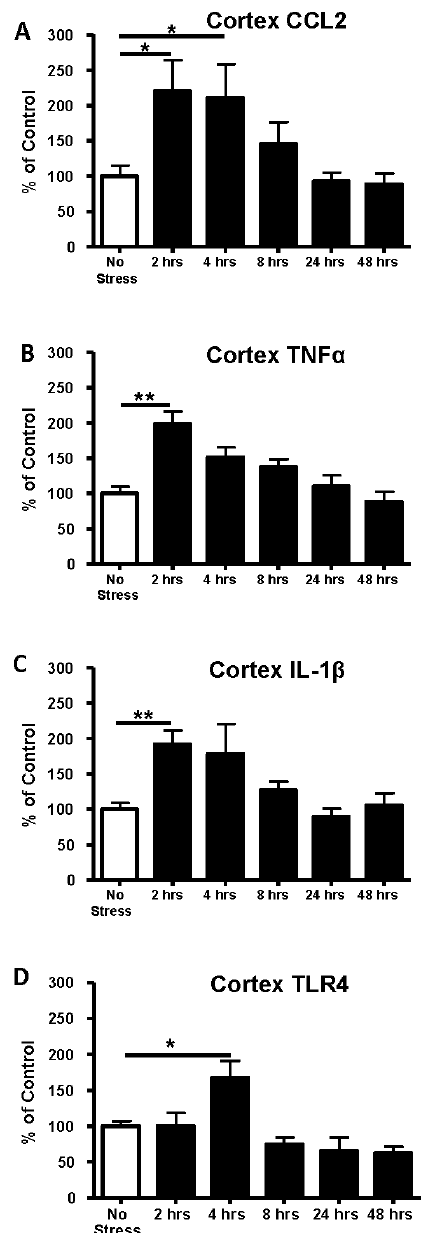
Figure 2. Time course of changes in cerebro-cortical mRNAs for CCL2, IL-1 β , TNF α , and